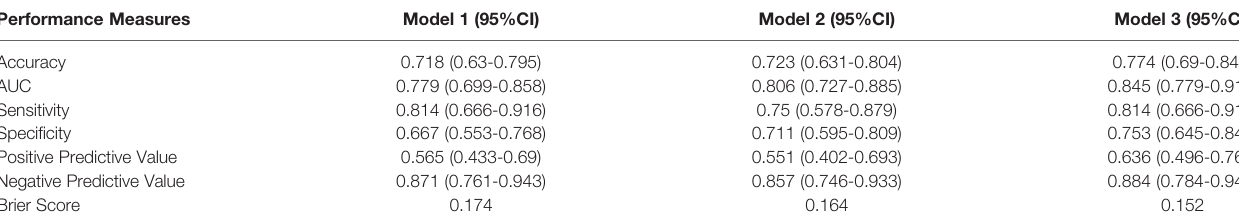
TABLE 3 | Performance measures of prediction models.